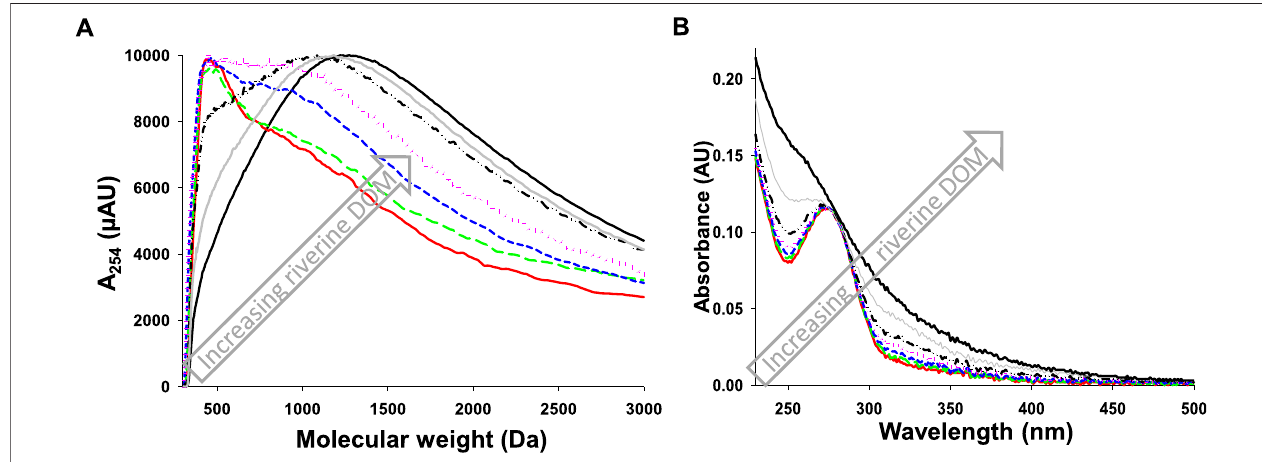
TABLE 3 | Linear correlation coef fi cients for best size-, absorbance-, and PARAFAC-based predictors of endmember contributions for A) % DOC and B) % A 254 (M p ).